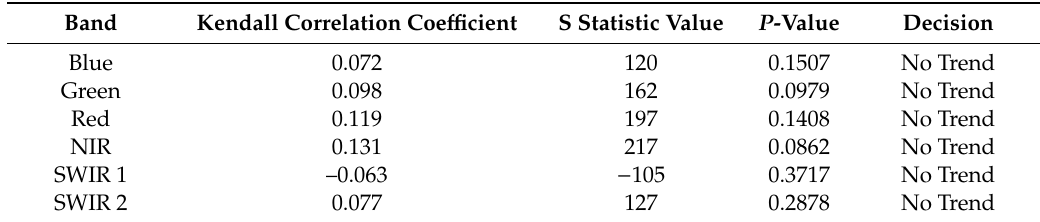
Figure 6. Virtual constellation – homogenized 4 sensor’s TOA reflectance trends for the 6 spectrally matched bands over Libya 4 site. Table 10. Seasonal Mann Kendall test result of Trend Analysis of Libya 4 (homogenized TOA reflectance